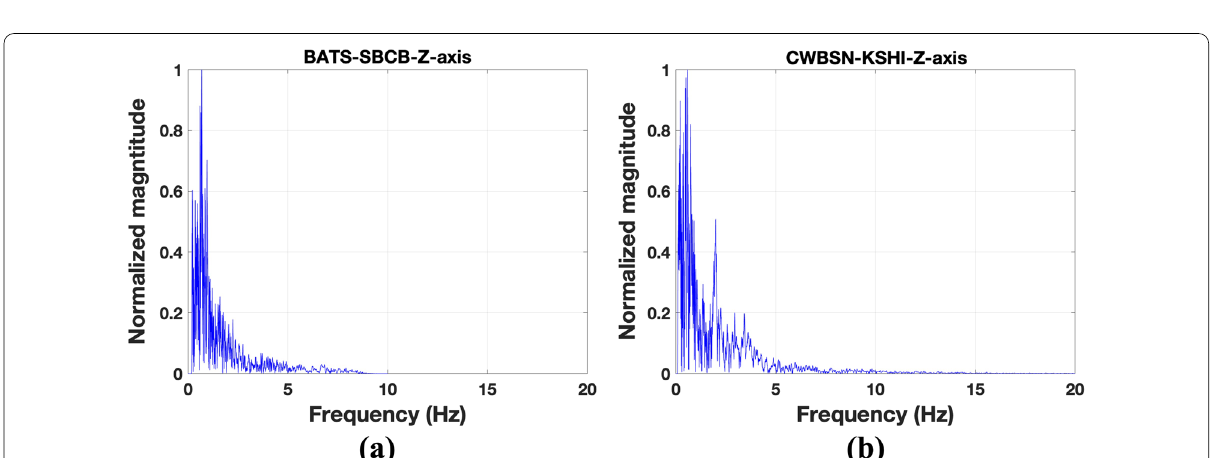
Fig. 5 FFT response spectra of the data recorded by the broadband seismographs a Trillium240/Q330HR and b Trillium 120 PH during the main shock of the M6.6 Yilan earthquake